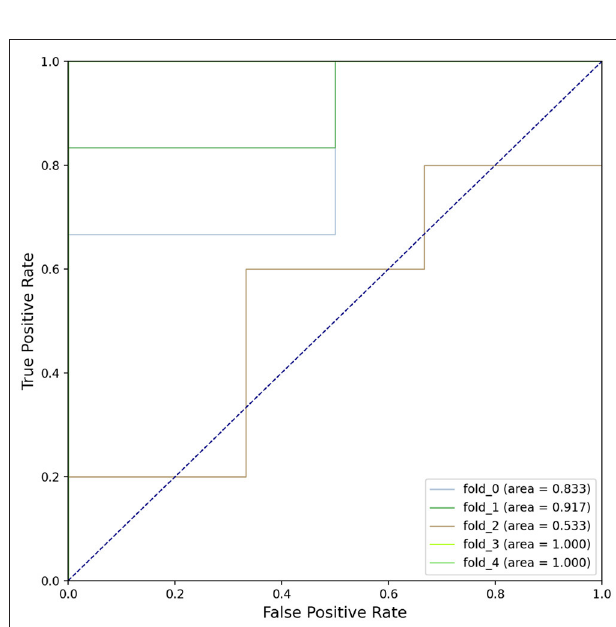
FIGURE 6 | The receiver operating characteristic (ROC) curve of the feedforward neural network (FFNN) model performing in 5-fold cross-validation’s test sets; each line represents the prediction of a fold of test samples in the validation.